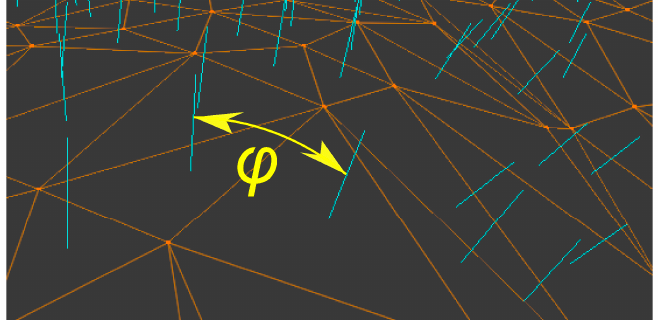
Figure 4. Oblique detail of a TIN model showing triangles in orange, triangle face normal vectors in blue, and dihedral angle, ϕ , between the normal vectors of two adjacent triangles as a yellow arc.